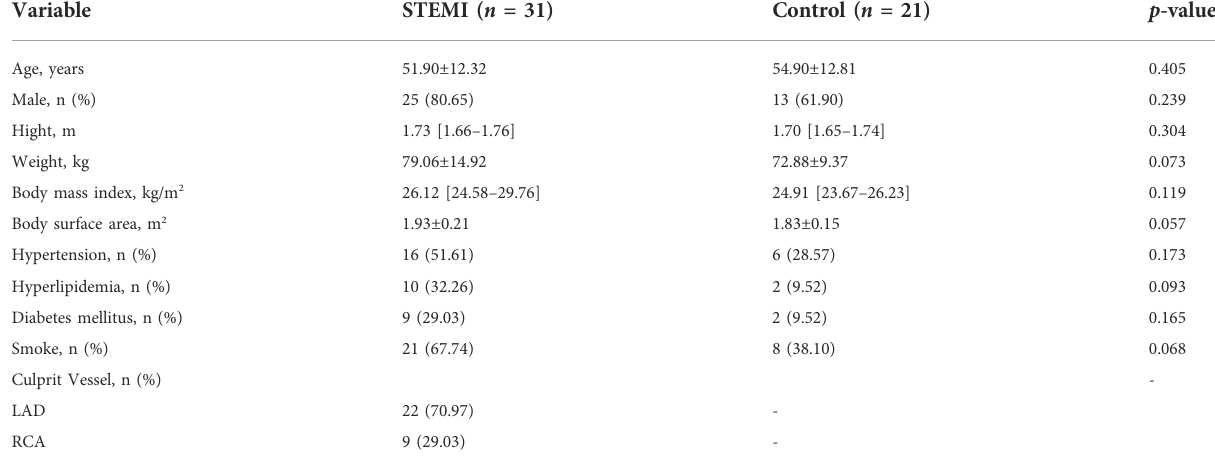
TABLE 1 Baseline characteristics of the study